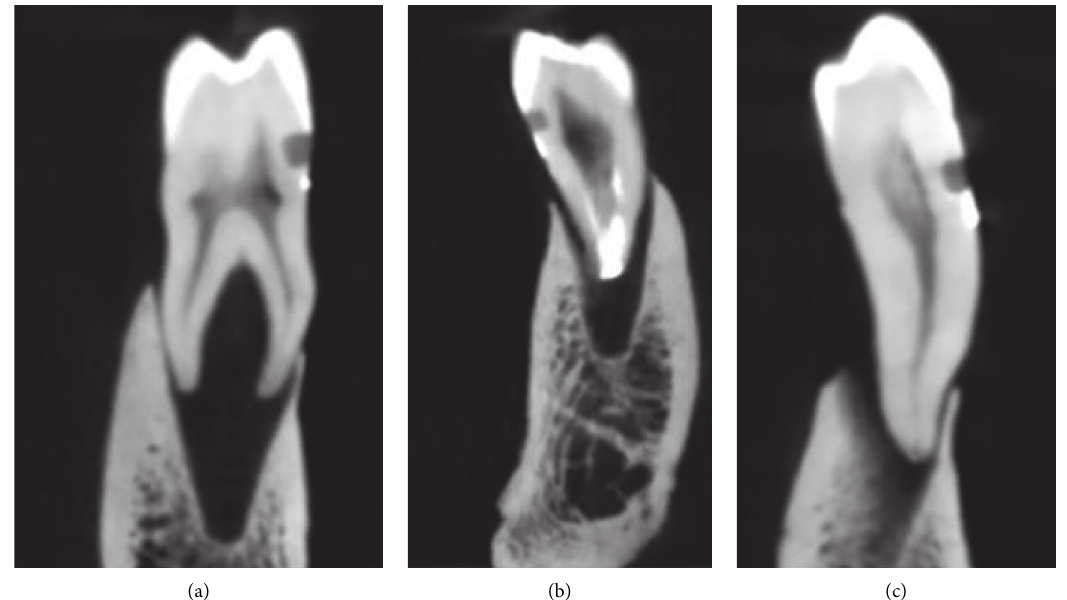
Figure 2: Marginal leakage on the gingival wall detected by the New Tom CBCTunit (New Tom GiANO; Quantitative Radiology, Verona, Italy). (a) Score 0. (b) Score 1. (c) Score 2.